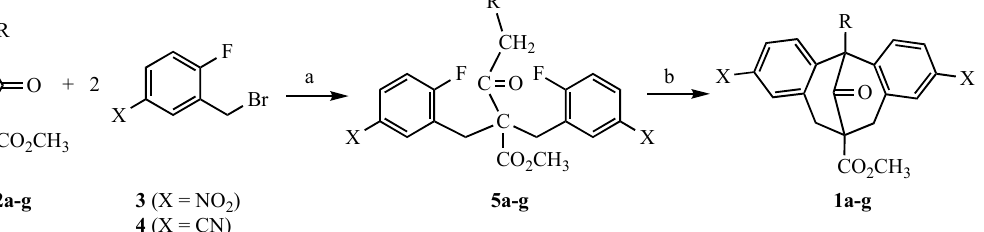
Scheme 1. Synthesis of substituted dibenzo[3.3.1]bicyclics. Key: (a) 2 equiv K 2 CO 3 , DMF 23 °C, 2